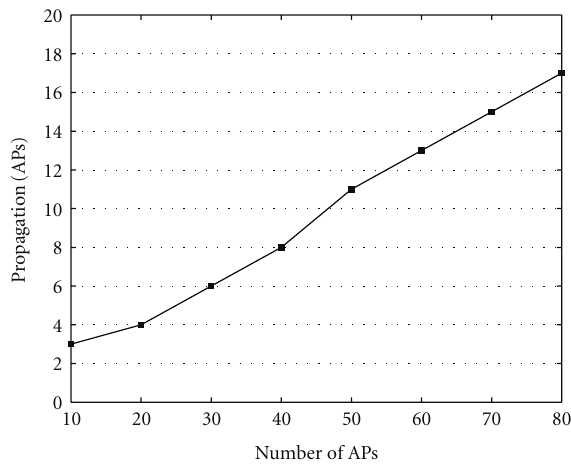
Figure 15: Propagation e ff ect when the AP that “fires” the execution of LAC is placed at the edge of the network.